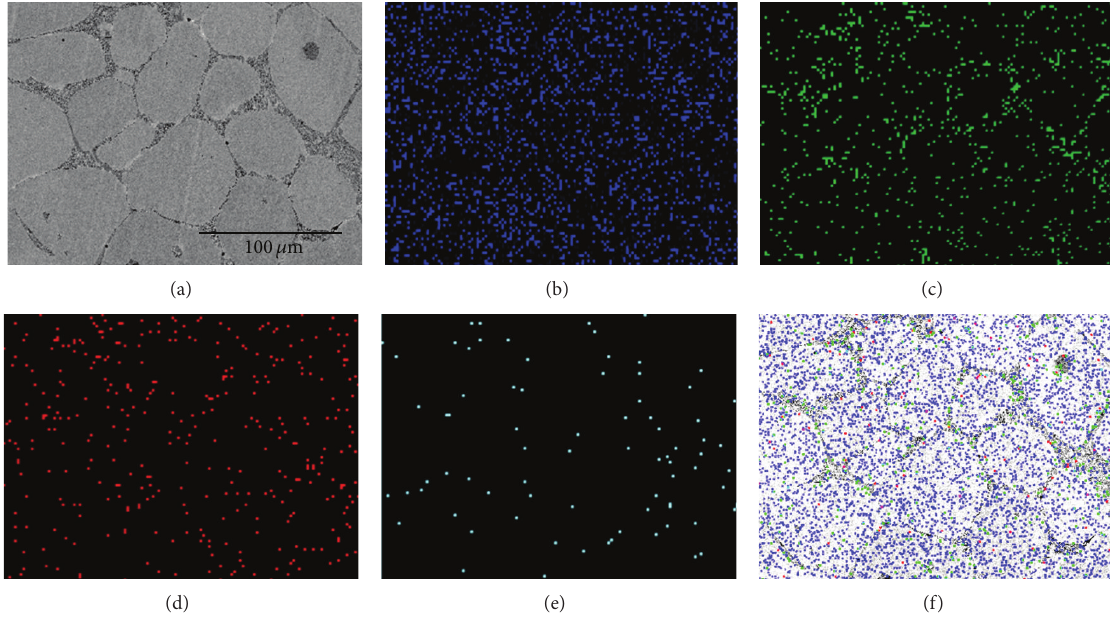
Figure 8: SEM-EDX elemental mapping of AISI D2, showing (a) SEM image, (b) Fe, (c) Cr, (d) C, (e) V, and (f)